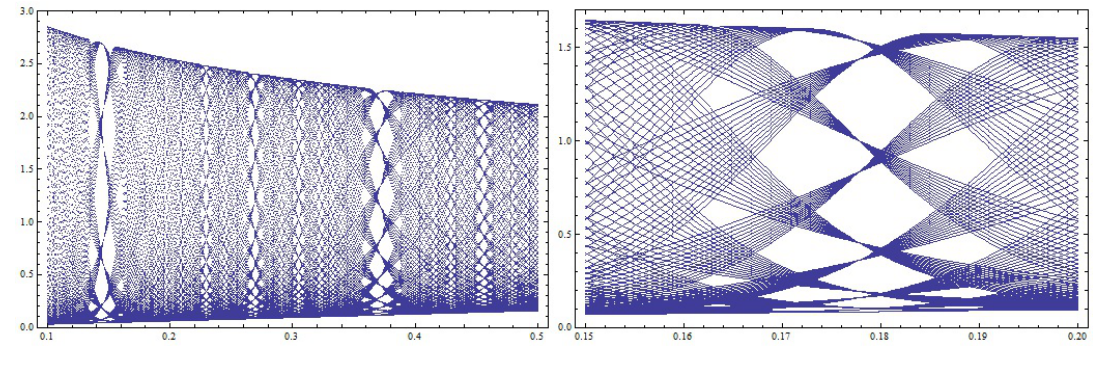
Figure 2. A bifurcation diagram in ( β − x )-plane. The plots are generated by Dynamica 3